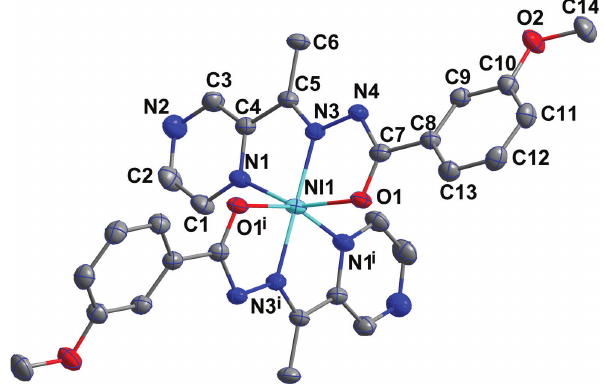
Table 2: Fractional atomic coordinates and isotropic or equivalent isotropic displacement parameters (Å 2